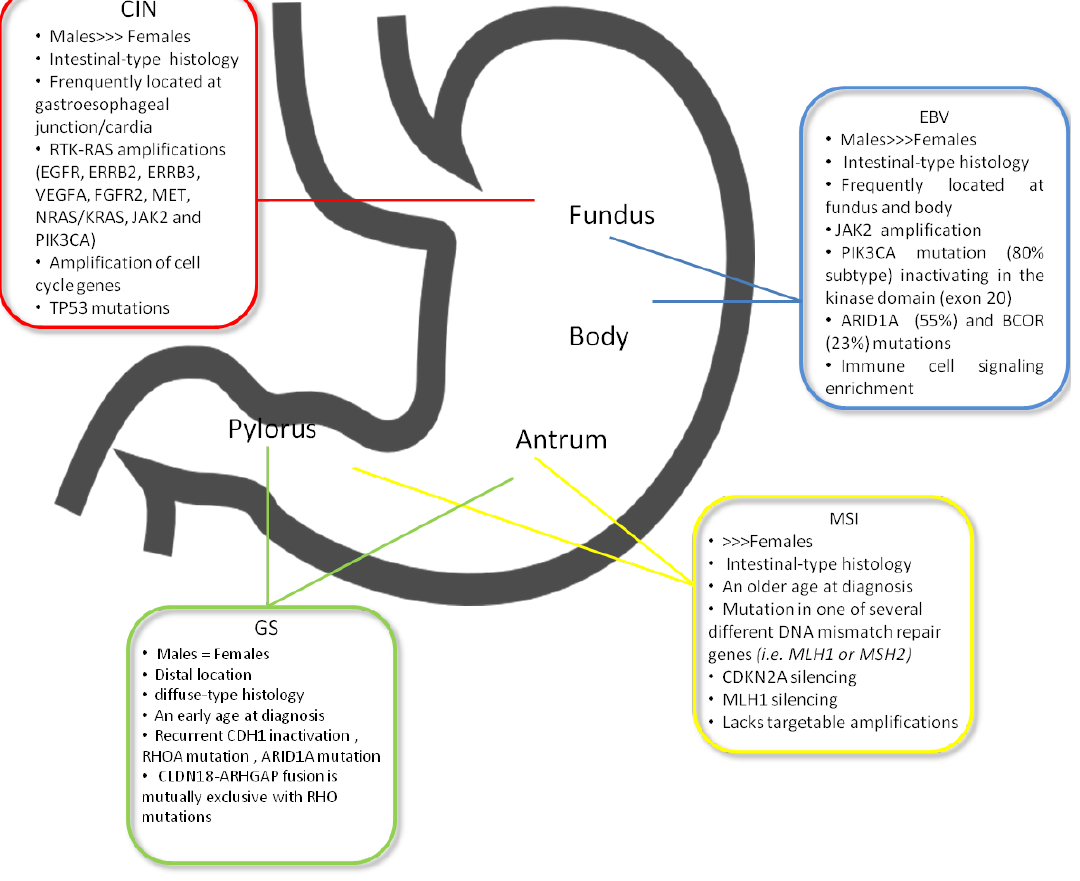
Figure 1. The most relevant clinic-pathological and molecular features of TCGA subtypes.